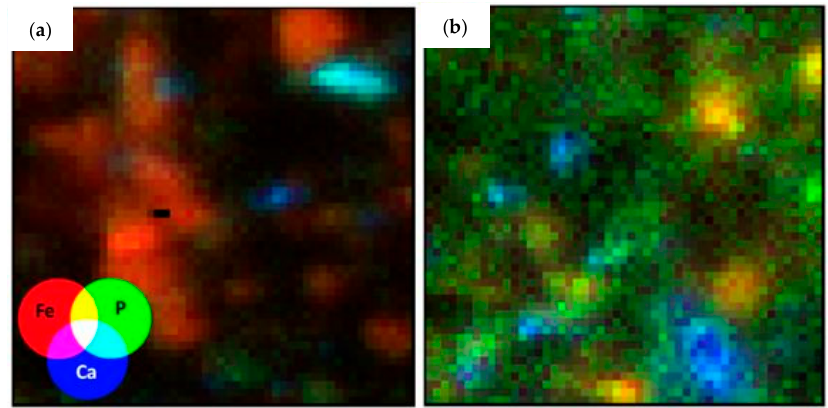
Figure 8. A tri-color map showing the distribution of phosphorus across rainforest samples ( a ) AT0Bp and ( b ) AT40Ah.